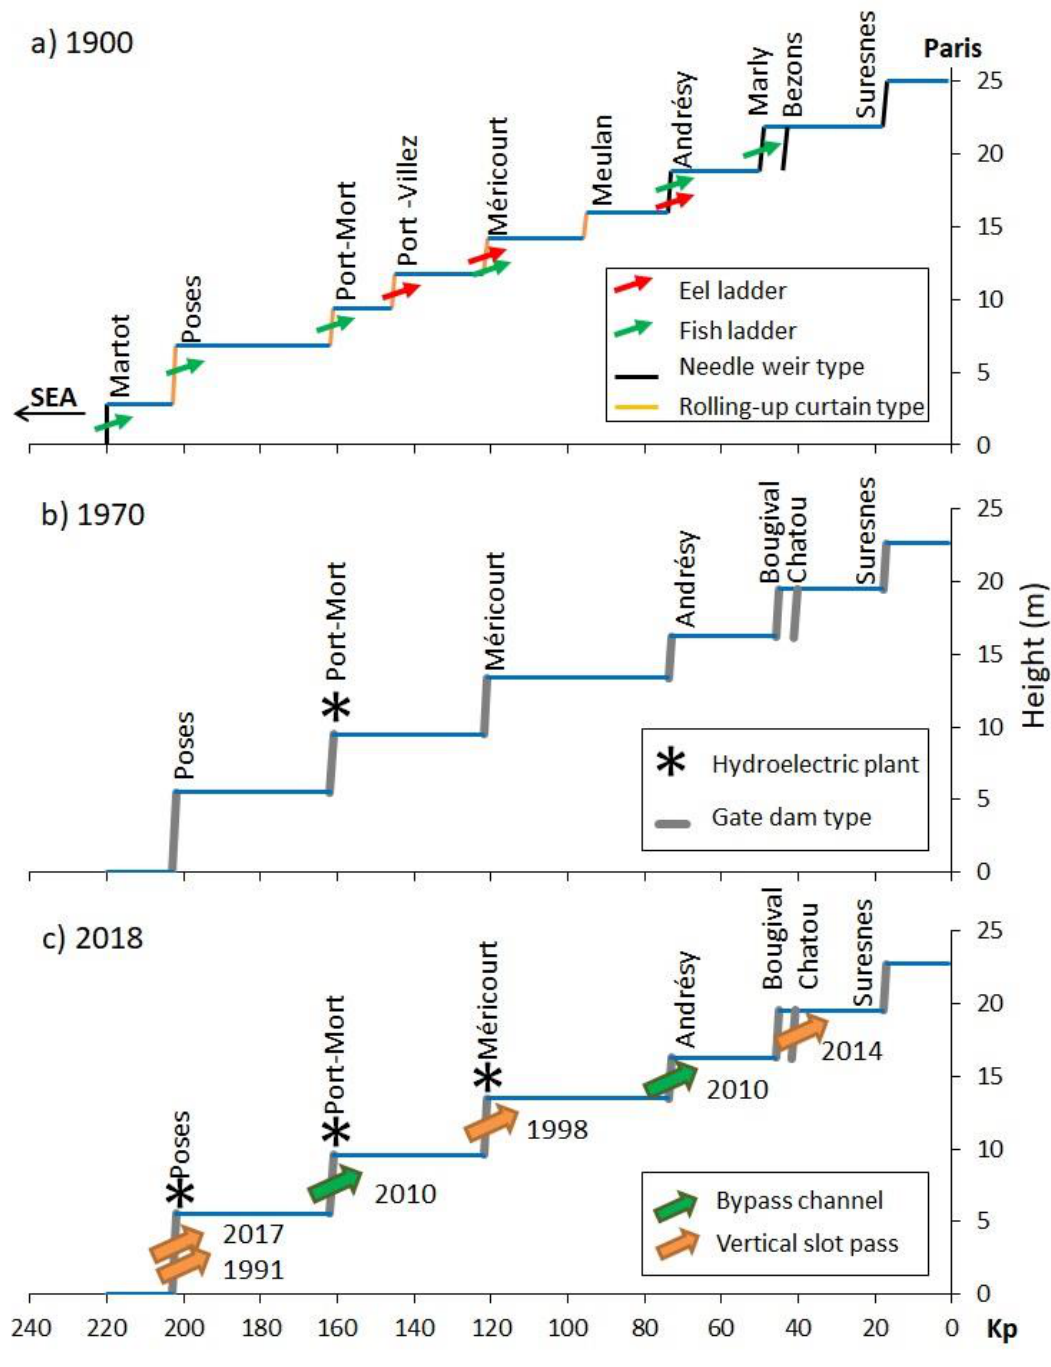
Figure 3. Longitudinal graphs of the location and cumulative fall height of weirs in 1900 ( a ), 1970 ( b ), and 2018 ( c ). Weir types, fish ladders, and passes, as well as hydroelectric plants, are indicated for each time period. The dates of construction of recent fish passes are specified beside arrows.